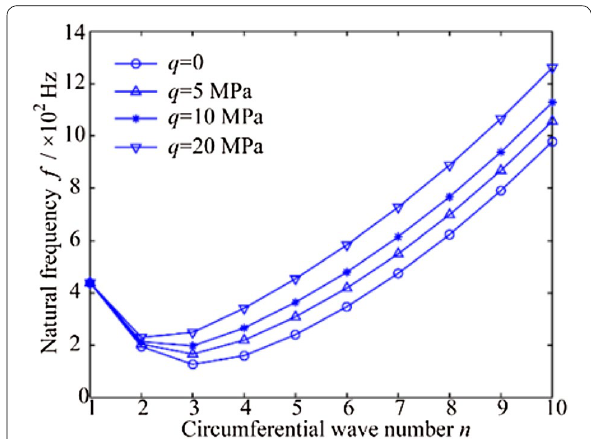
Figure 6 Variation of the natural frequency against n for several uniformly distributed pressures